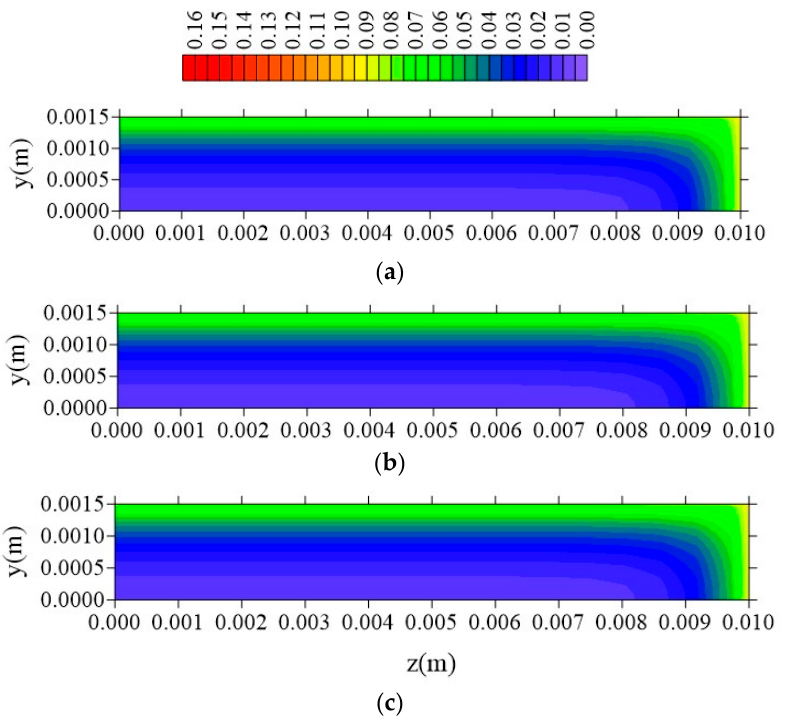
Figure 18. Distribution of entrapped solute concentration (S in kg/kg) in plan x = R x /2 for different distances l x (t = 211 h, Cases 8, 9, and 10). In which ( a ) l x = 0.01 m; l y = 0.01 m and l z = 0.1 m ; ( b ) l x = 0.1 m; l y = 0.01 m and l z = 0.1 m ; ( c ) l x = 1 m; l y = 0.01 m and l z = 0.1 m .